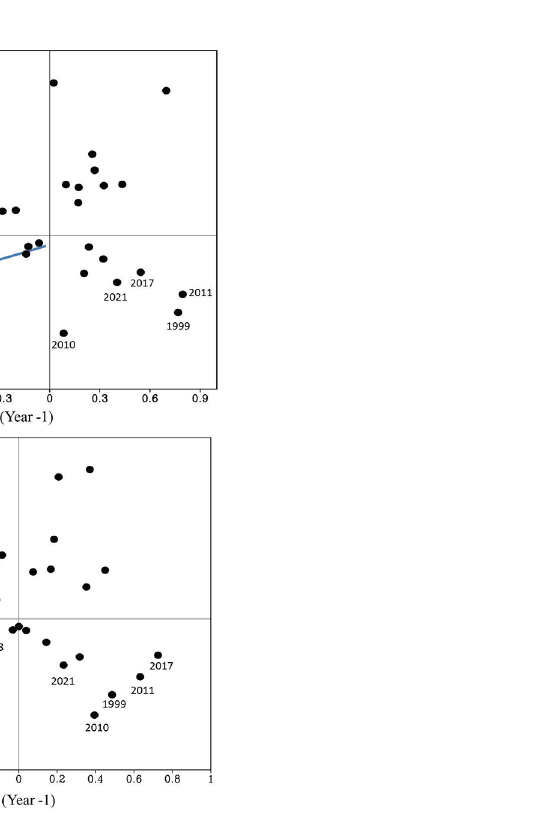
FIGURE 1 Relationship of the SETIO SLA (A) and SSTA (B) in fall with the Niño3.4 index one year later, respectively. Units are °C for Niño3.4 index and decimeter for SLA. Black dots stand for the annual observations, with the year 2020 highlighted in red. Blue dots denote IRI prediction of the fall 2020 Niño3.4 index made from the initial conditions in January through August of 2020. Blue line denotes regressed linear relation between the SLA and the Niño3.4 index one year later in the third quadrant. Orange dot denotes the prediction of the fall 2020 Niño3.4 index using the linear regression model with the fall 2019 SLA in the SETIO as the predictor. Correlation coef fi cients in the third quadrant are shown in the lower left of each